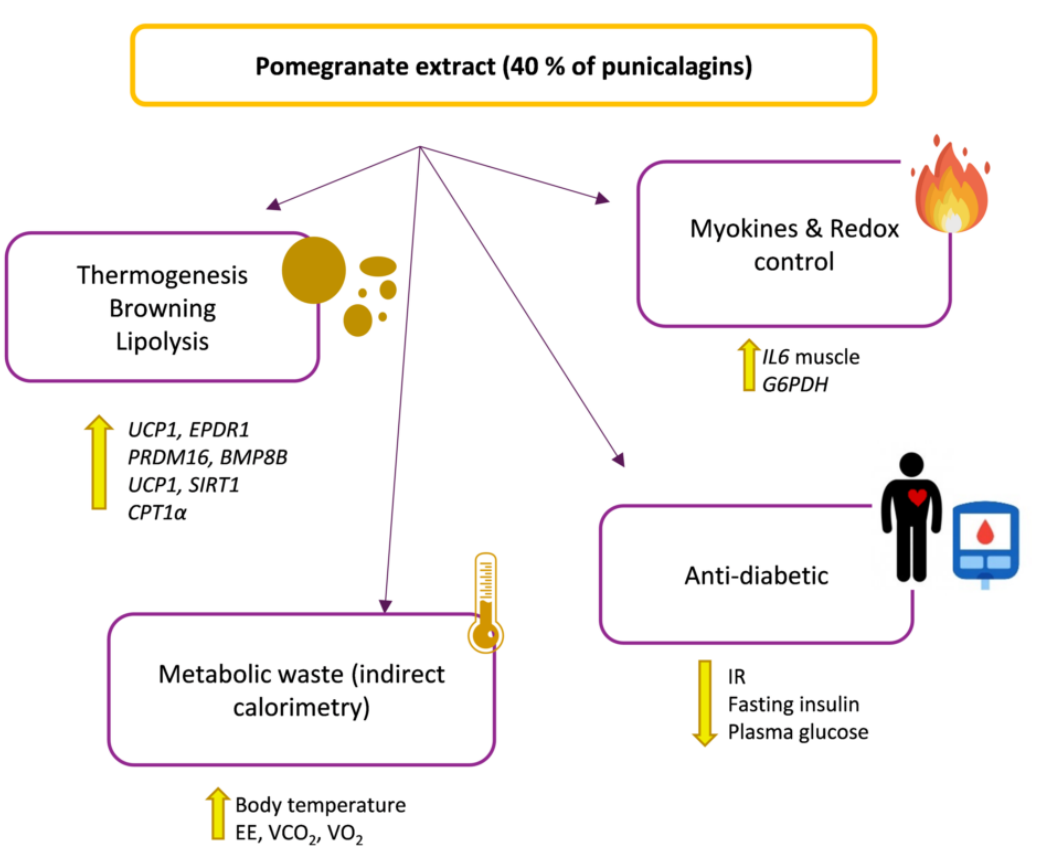
Figure 9. Proposed model of PomE to alleviate the metabolic stress associated to HFD-induced obesity.